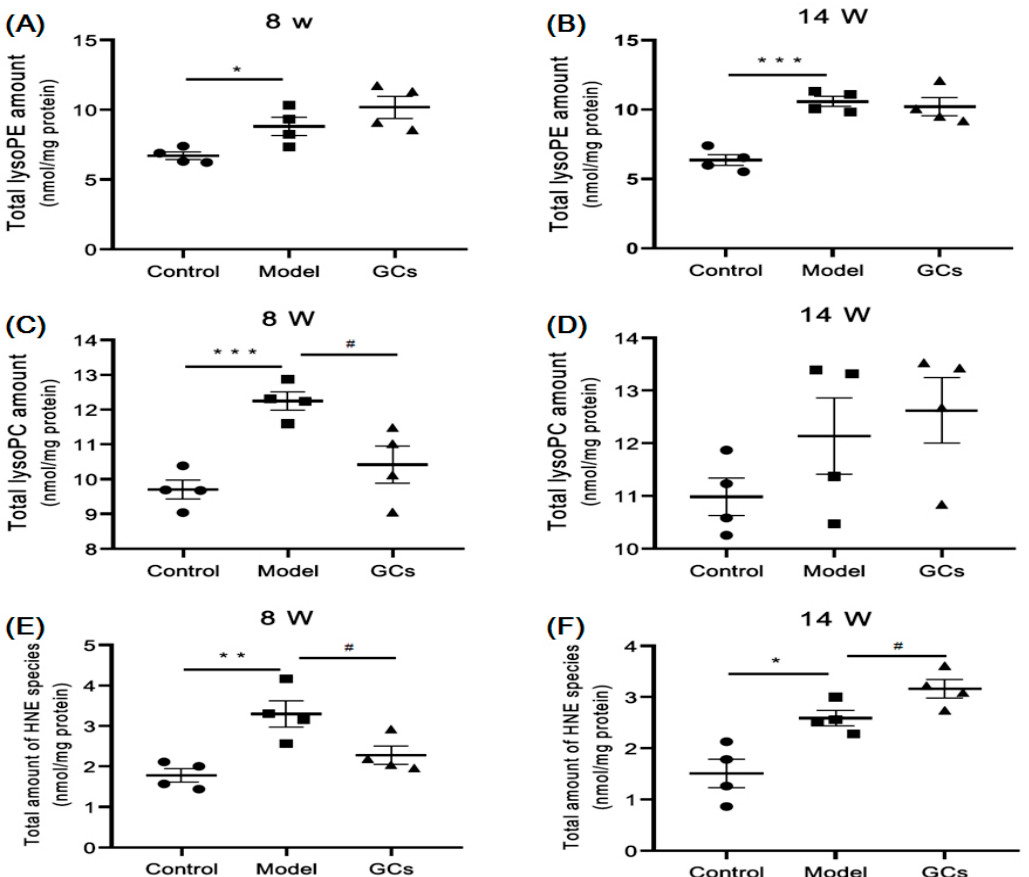
Figure 4. Comparison of the total levels of lysophospholipids and 4-hydroxyalkenal species in renal tissues from MRL/lpr mice at different lupus nephritis (LN) states. The kidney samples of the control ( n = 4), model ( n = 4), and GCs ( n = 4) groups were collected at 8 (pre-LN) and 14 weeks of age (LN), respectively. Lipidomics analysis of lysophospholipids, including ethanolamine lysoglycerophospholipid (lysoPE) (Panels A and B ) and choline lysoglycerophospholipid (lysoPC) (Panels C and D ), and 4-hydroxyalkenal species (Panels E and F ) was performed by the MDMS-SL technology. The filled circle, square and triangle represent the control, model, and GCs group, respectively. The data present means ± SEM from different groups. * p < 0.05, ** p < 0.01, and *** p < 0.001 compared with those in the control group. # p < 0.05 compared with those in the model group. HNE denotes 4 ‐ hydroxyalkenal.